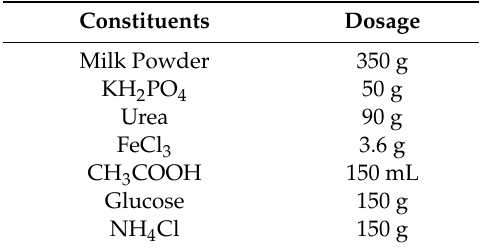
Table 2. The complete composition of synthetic wastewater.